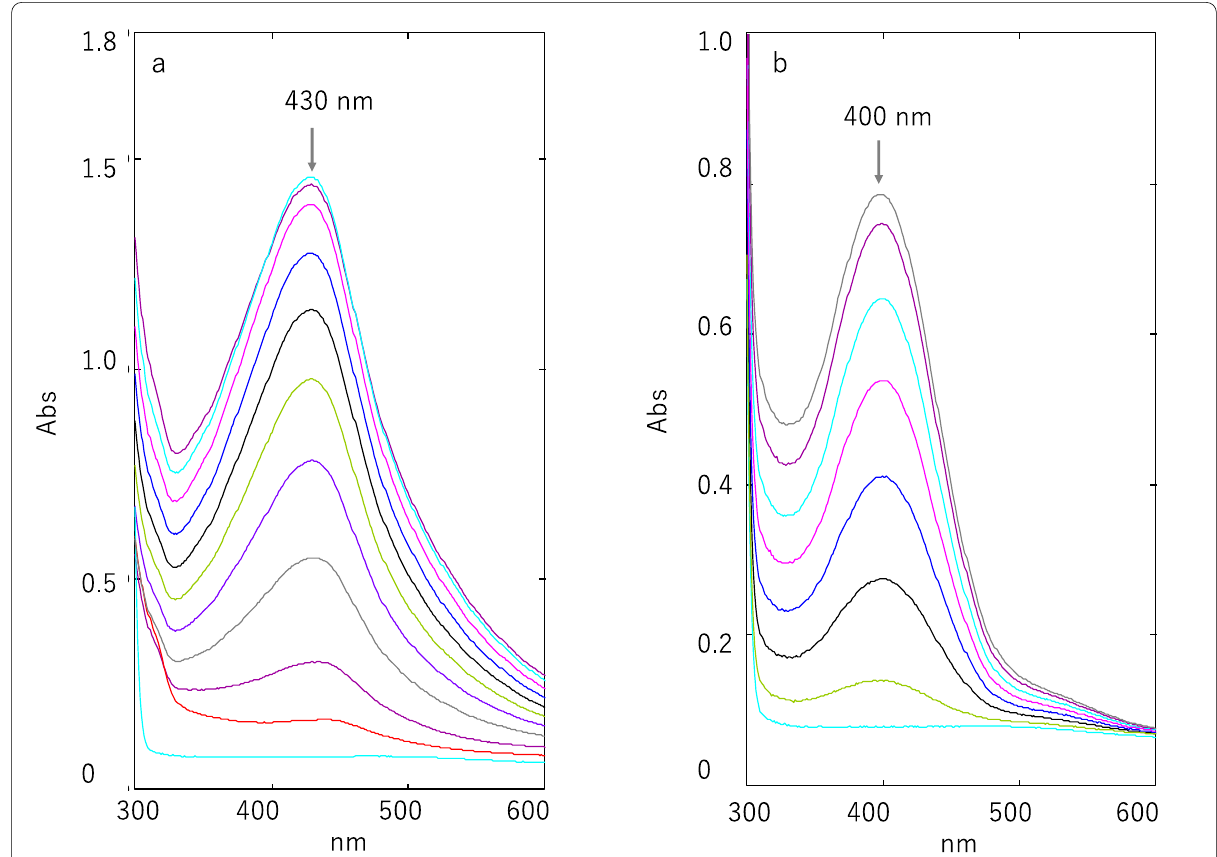
Fig. 3 Spectra change of 3-methylcatechol and 4-methylcatechol oxidized by laccase. Spectral changes were recorded at intervals of 2 min. a 3MC;